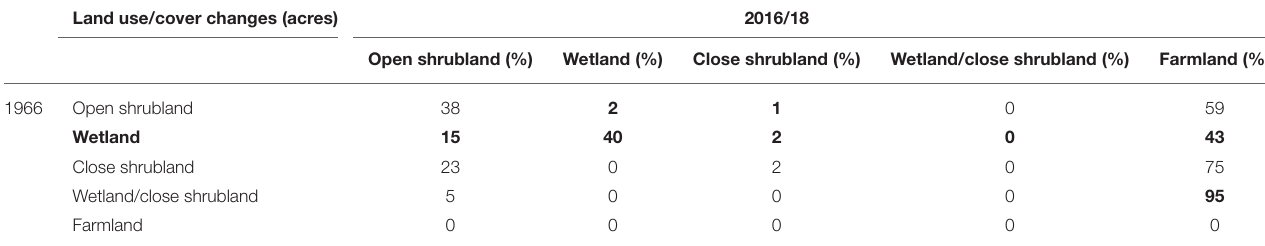
TABLE 3 | Inter-class land cover changes (1966–2016/18). Land use/cover changes (acres)